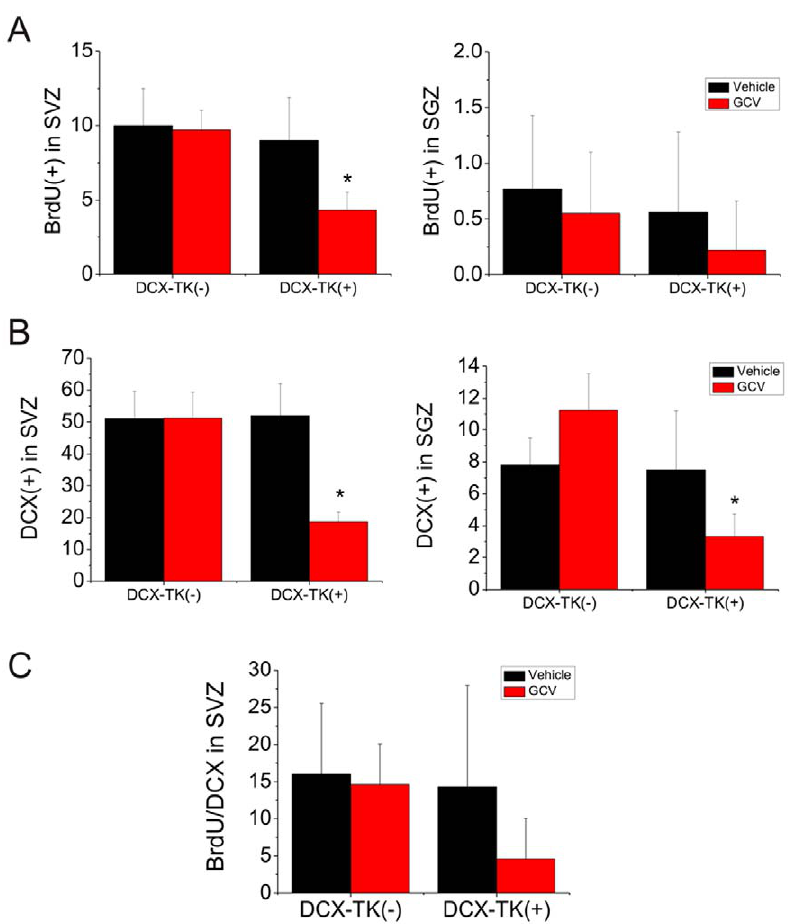
Figure 5. DCX- and BrdU-positive cells in the SVZ and SGZ 12 weeks after depletion of neurogenesis followed dMCAO. ( A ) Qualification of BrdU-immunoreactive cells in the SVZ (left panel) and SGZ (right panel) of vehicle- or GCV-treated middle-aged DCX-TK ( 2 ) and DCX- TK ( + ) mice at 12 weeks after dMCAO. * P , 0.05. ( B ) Qualification of DCX-immunoreactive cells in the SVZ (left panel) and SGZ (right panel) of vehicle- or GCV-treated middle-aged DCX-TK ( 2 ) and DCX-TK ( + ) mice at 12 weeks after dMCAO. * P , 0.05 ( C ) Qualification of DCX/BrdU-positive cells in the SVZ of vehicle- or GCV-treated DCX-TK ( + ) and DCX-TK ( 2 ) mice at 12 weeks after depletion of neurogenesis.